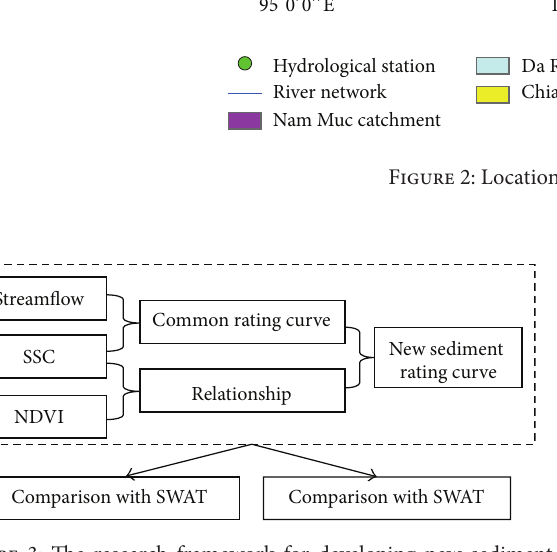
Figure 3: The research framework for developing new sediment rating